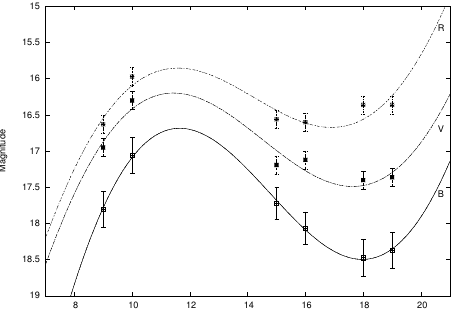
Figure 6. The observations of the 1989 fade of OJ 287 with the Nordic Optical Telescope and the Jacobus Kapteyn Telescope at La Palma, with 2 σ errorbars. Here we plot the magnitudes in three filters B, V and R: the I band data were too few to show a significant variation. The lines are fifth order polynomial fits through the data points. We note that the dip on 18 May was deepest in the B band and less deep going to longer wavelengths. There is a possible time delay in the sense that the dip starts from longer wavelengths and happens later at shorter wavelengths. At 37 GHz the minimum took place on 3 May